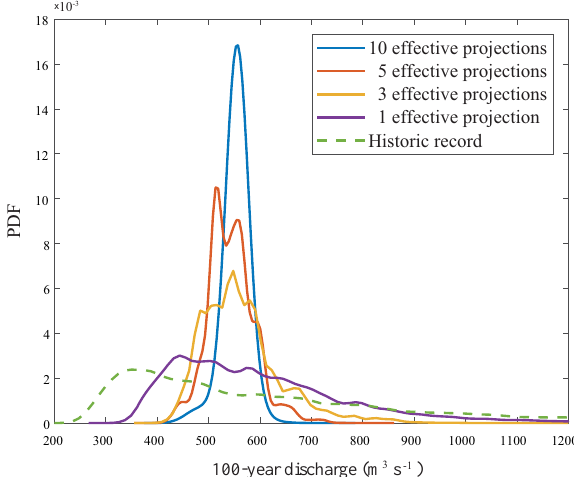
Figure 5. The 100-year discharge PDF from initial parameter distri- bution when estimated based on the historic record (dashed) versus different numbers of effective projections, for years